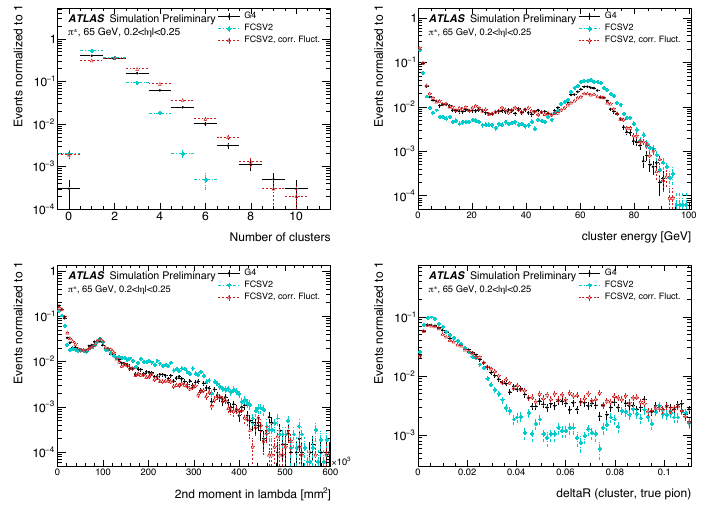
Figure 6. Comparison of the Gaussian fluctuation model to the default FCSV2 version and to G4 simulation, using pions of 65 GeV energy and 0 . 2 < | η | < 0 . 25. With the correlated fluctuations, several shape variables demonstrate improved modelling